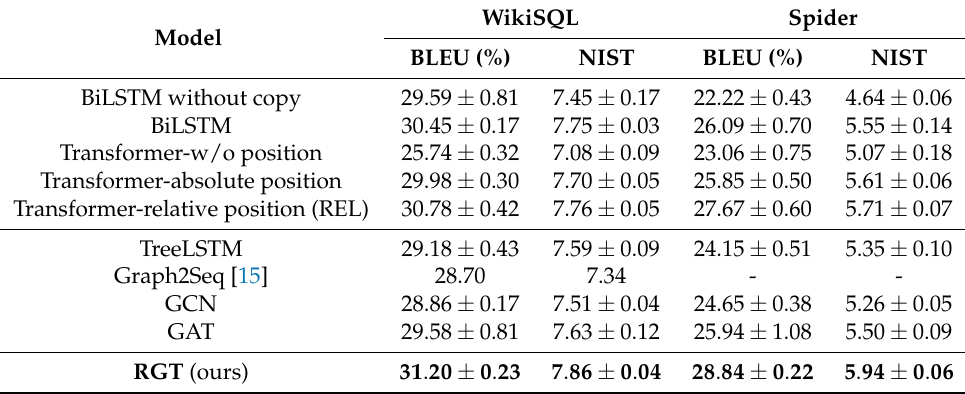
Table 5. Main results for all models. Bold means the best